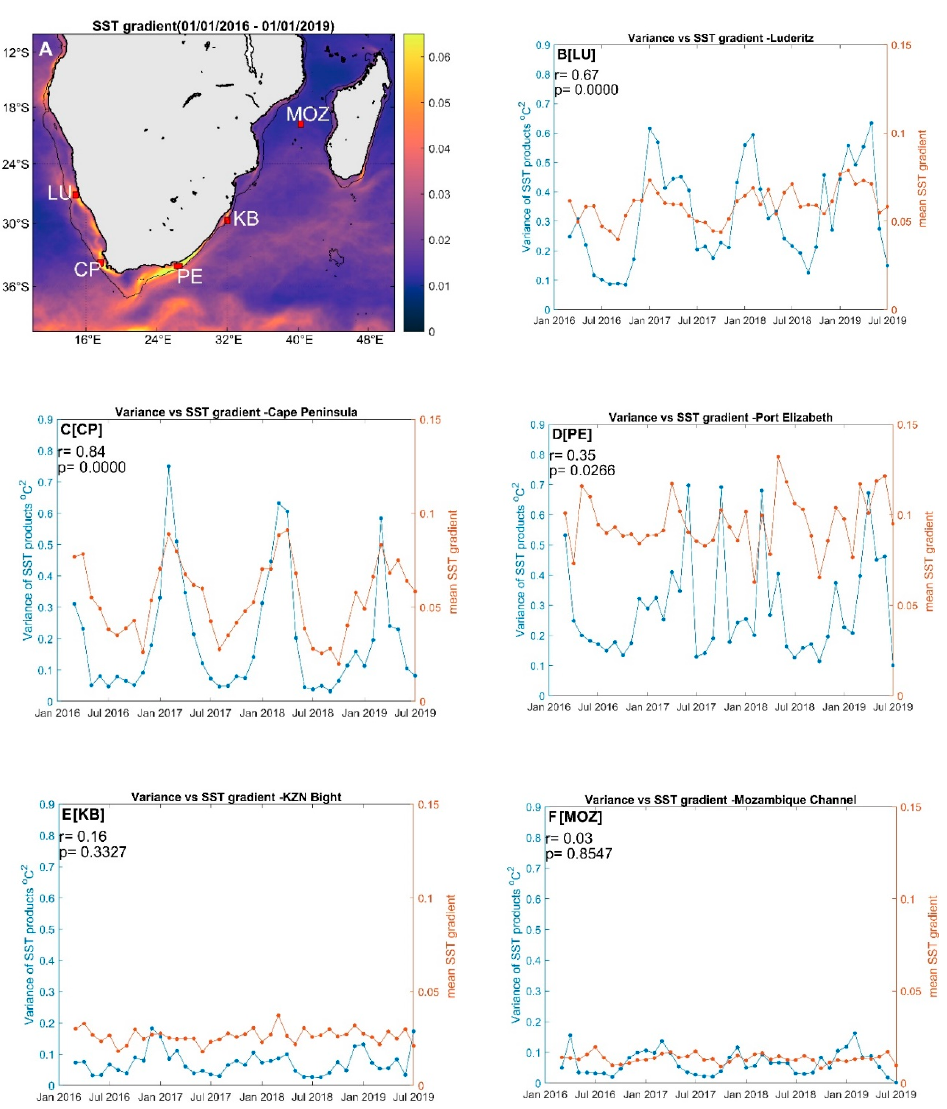
Figure 5. ( A ) shows the mean SST gradient, calculated using the high resolution L4 SST products, as well as the position of the case study regions. The thin black contour shows the 1000 m isobath. The remaining panels ( B – F ) show timeseries of the mean SST gradient (orange) and SST variance (blue) for the Lüderitz, Cape Peninsula, Port Elizabeth, KZN Bight and Mozambique Channel, respectively. Both the SST gradient and variance were calculated daily and then averaged to monthly time steps over a three-year period (1 January 2016 to 1 June 2019). The correlations (r) between SST variance and gradients and significance (p) are presented in the top left corner of each line graph.